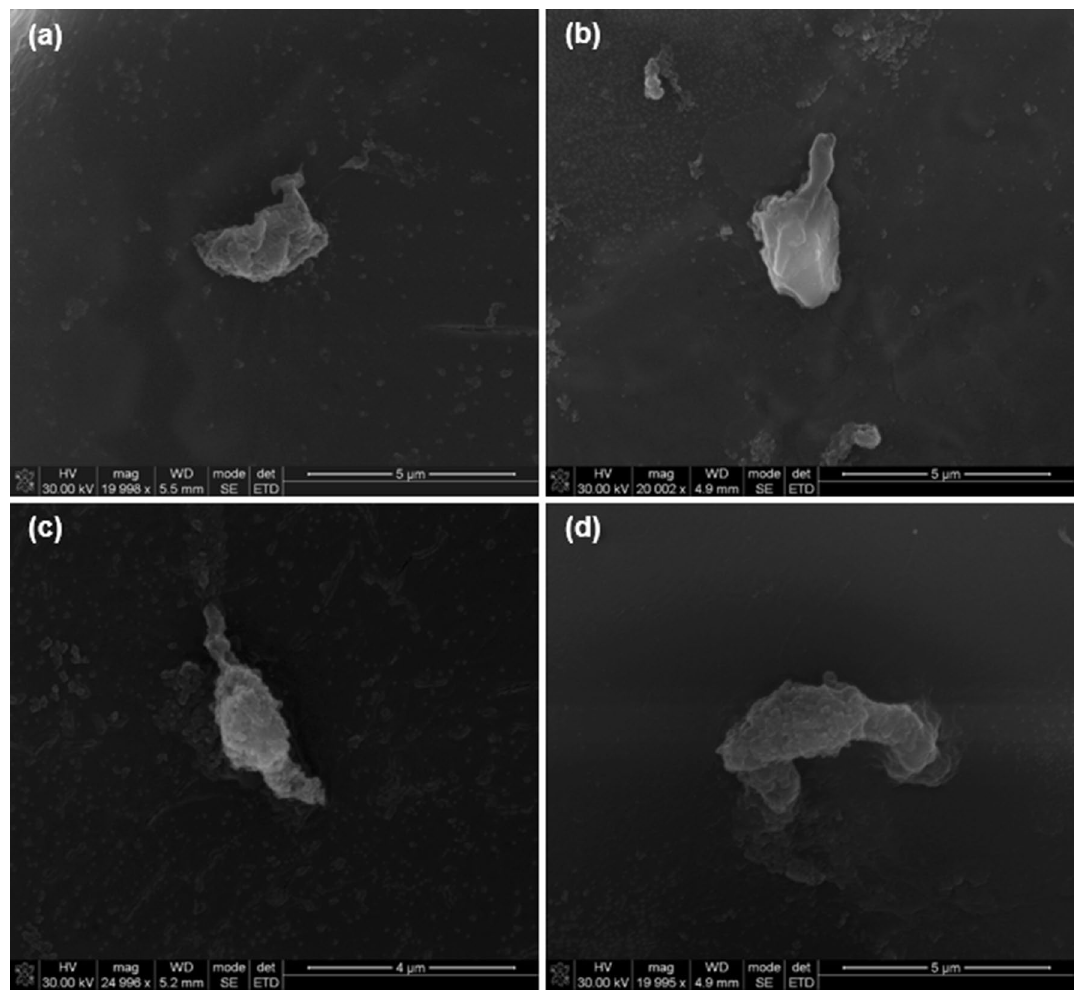
Figure 12. Representation of the PC12 attachment on cryosponge surfaces showing potential cell attachment ( a ) CHT; ( b ) CHT-mPEG; ( c ) CHT-mPEG-CHO; and ( d )